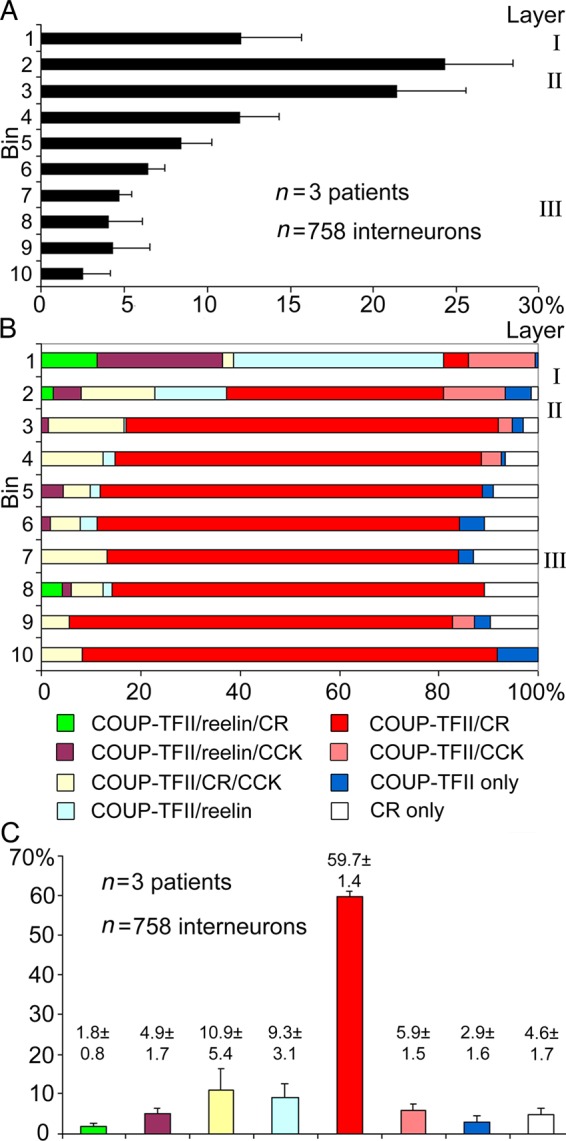
Distribution of strongly COUP-TFII-positive interneurons and colocalization patterns with calretinin, reelin, and CCK displayed in 10 radial bins from the pia to the bottom of layer III. Pyramidal cells positive for CCK were excluded. (A) Average (±SD) proportions of COUP-TFII-positive cells per bin. (B) Depth profile of the colocalization distribution of the 4 molecules shown as average of the 3 patients. Most COUP-TFII-positive cells were positive for at least one of the 3 molecules. All reelin-positive cells were COUP-TFII-positive and mostly located in layers I and upper II. Few calretinin-positive cells were COUP-TFII-negative. (C) Distribution of cells (mean ± SD) showing different colocalization patterns summed from all supragranular layers. Most COUP-TFII-positive cells are immunopositive for calretinin, and/or CCK, and/or reelin, and those immunonegative for all 3 molecules represent on average only 2.9% of cells. Note the small variation between the 3 individuals. Colour-coding of diagrams in (B) and (C) is identical.